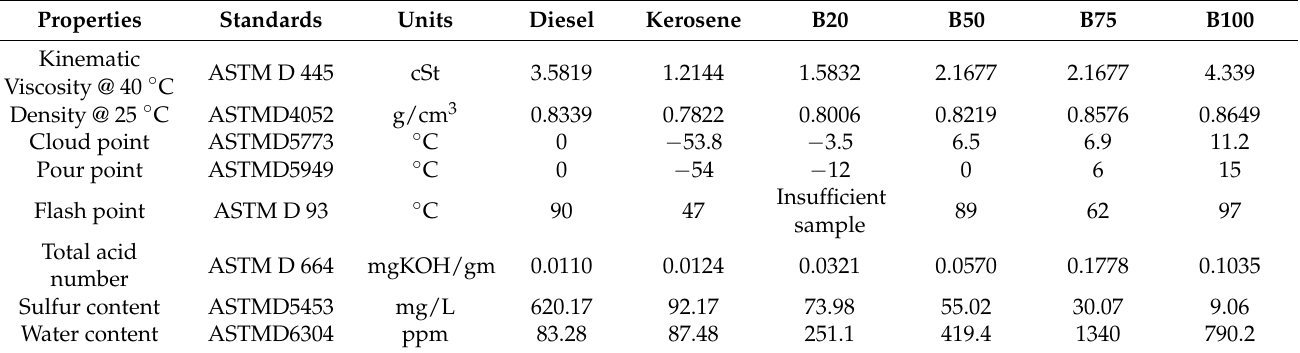
Table 2. Properties of the diesel, kerosene and biodiesel